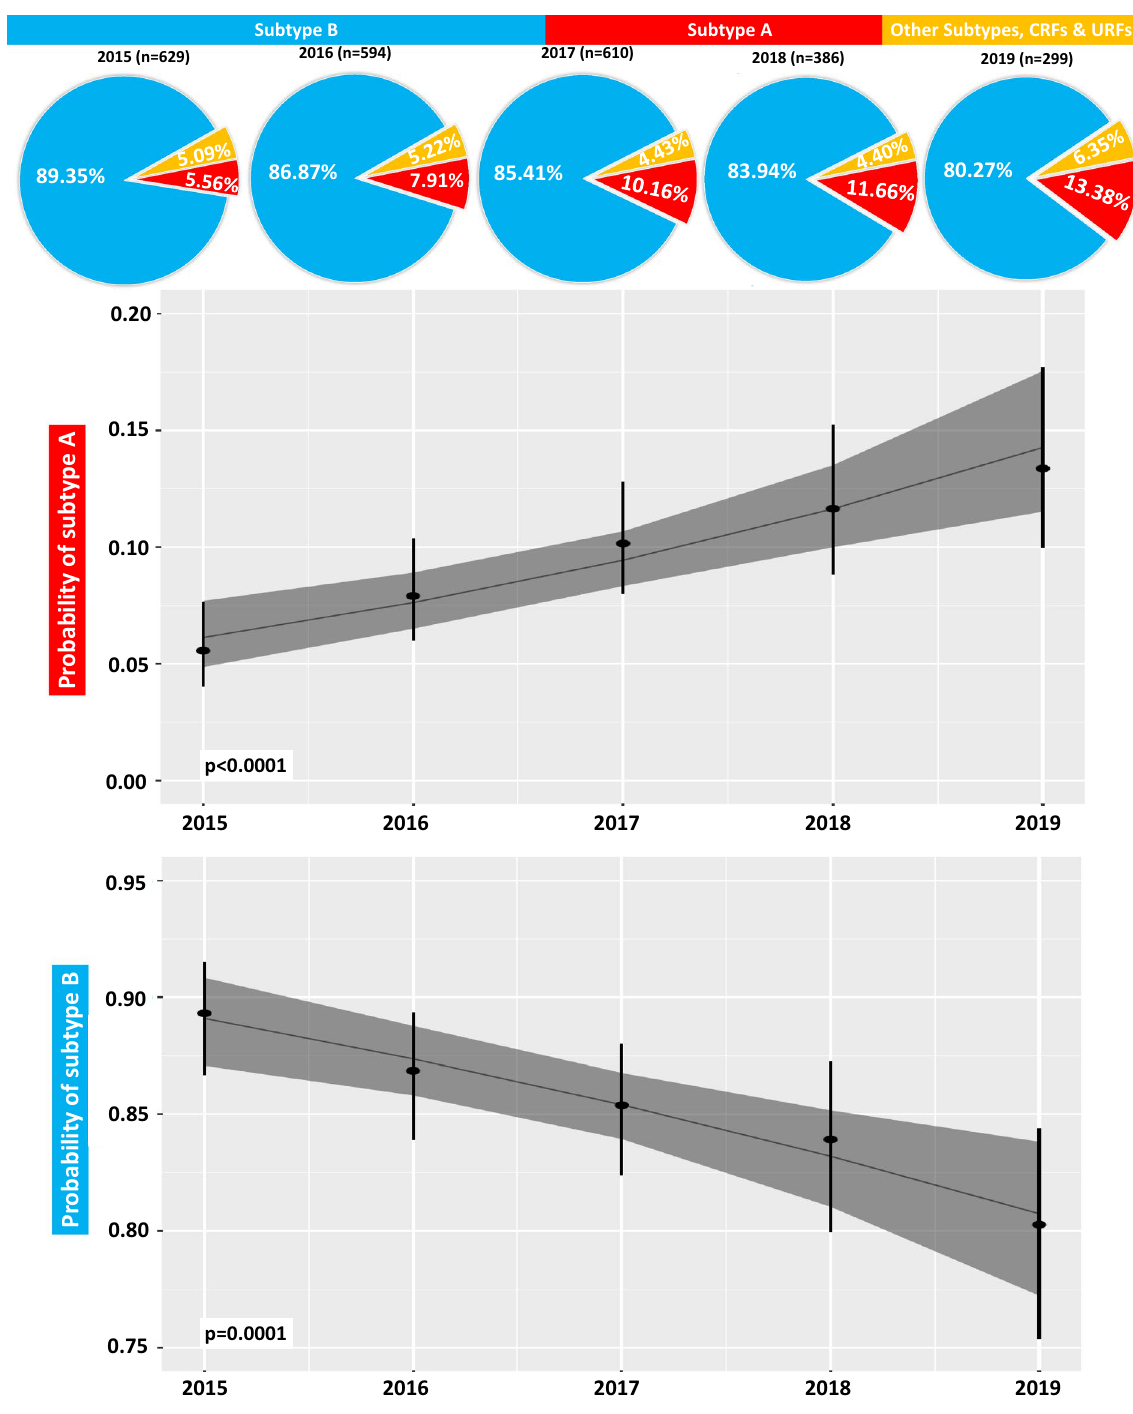
Figure 8. Logistic regression estimates for time trends between 2015–2019 for subtype B and subtype A, together with pie charts of subtype prevalence each year. Dots indicate the percentage per year and vertical bars 95% confidence intervals for the percentages with a vertically presented logistic regression time trend line with dark-grey shaded 95% confidence intervals for the regression estimate. Only limited numbers of subtypes other than B and A each year were found; these non-B, non-A subtypes were grouped as "other” on the pie